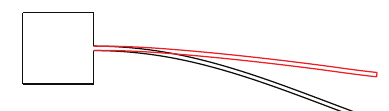
Figure 10: Comparison between deflections, v (cid:8) 0 . 34m/s, plate